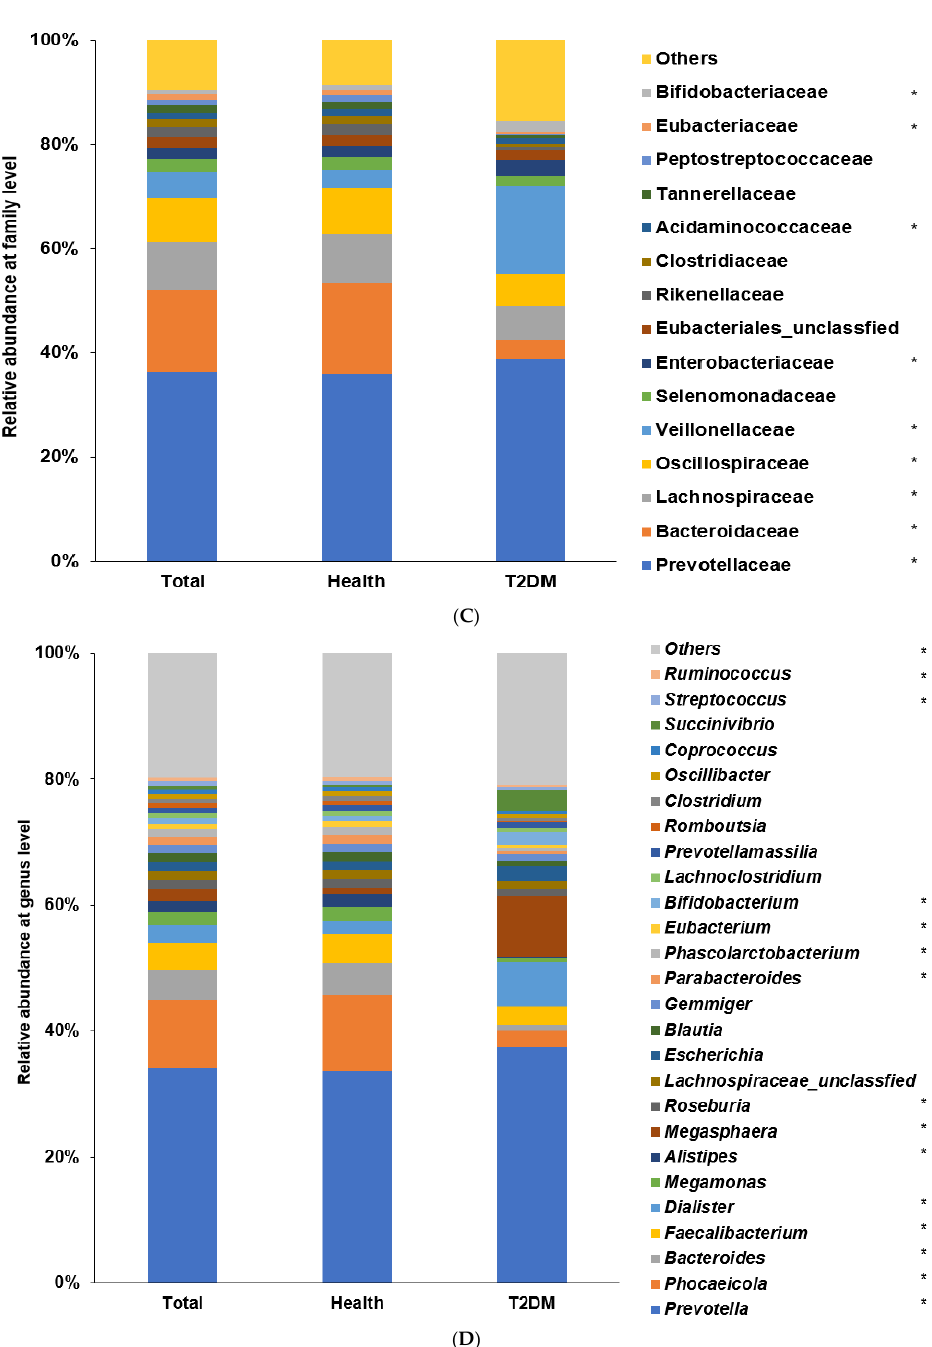
Figure 3. Fecal bacterial compositions between type 2 diabetes (T2DM) and healthy Asians. ( A ) Rela- tive abundance of fecal bacteria in T2DM and healthy adults in ET-L at the family level; ( B ) Relative abundance of fecal bacteria in T2DM and healthy adults in ET-L at the genus level; ( C ) Relative abundance of fecal bacteria in T2DM and healthy adults in ET-P at the family level; ( D ) Relative abundance of fecal bacteria in T2DM and healthy adults in ET-P at the genus level; * Significant differences between T2DM and healthy groups at p < 0.00001 (Bonferroni-corrected p value). ET-L: Enterotype Lachnospiraceae; ET-P: Enterotype